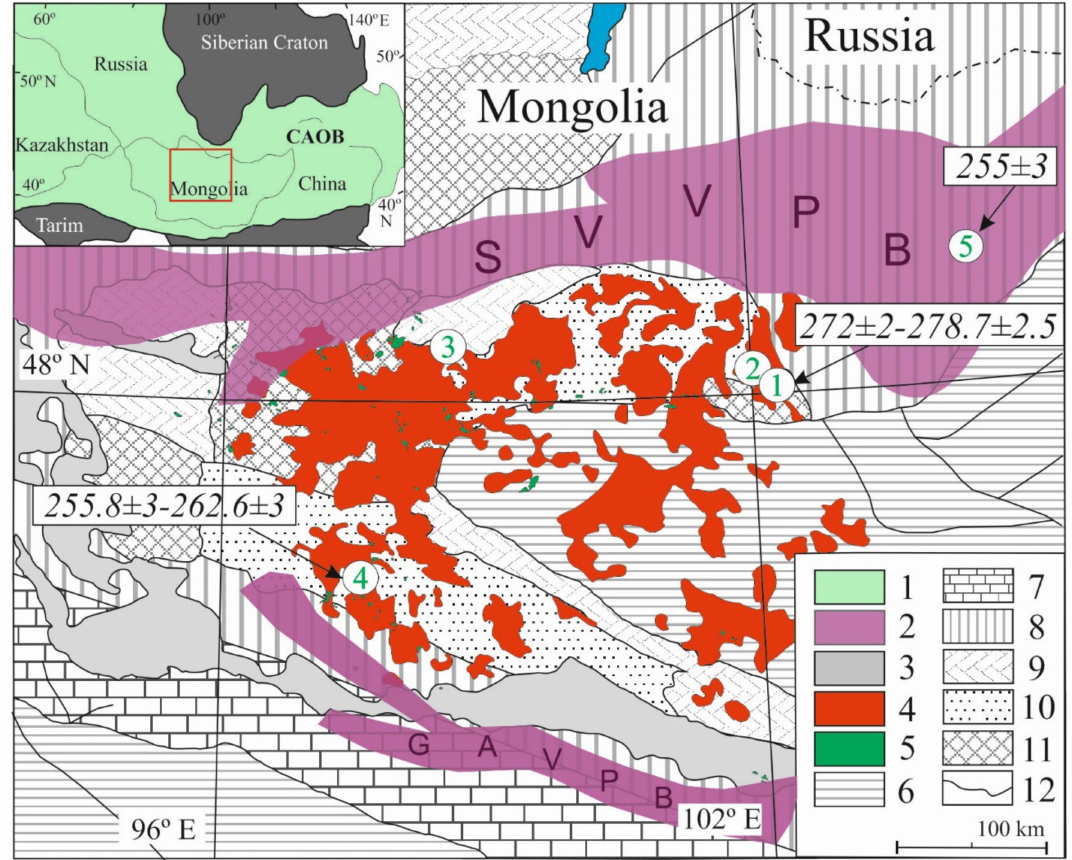
Figure 1. A geologic map of the mafic-ultramafic massifs in Khangai batholith (after [20]). 1—Central Asian Orogenic Belt (CAOB); 2—volcano-plutonic belt; 3—Mesozoic–Cainozoic troughs; 4—Late Paleozoic granitoids of the Khangai batholith; 5—Permian gabbros of the Khangai